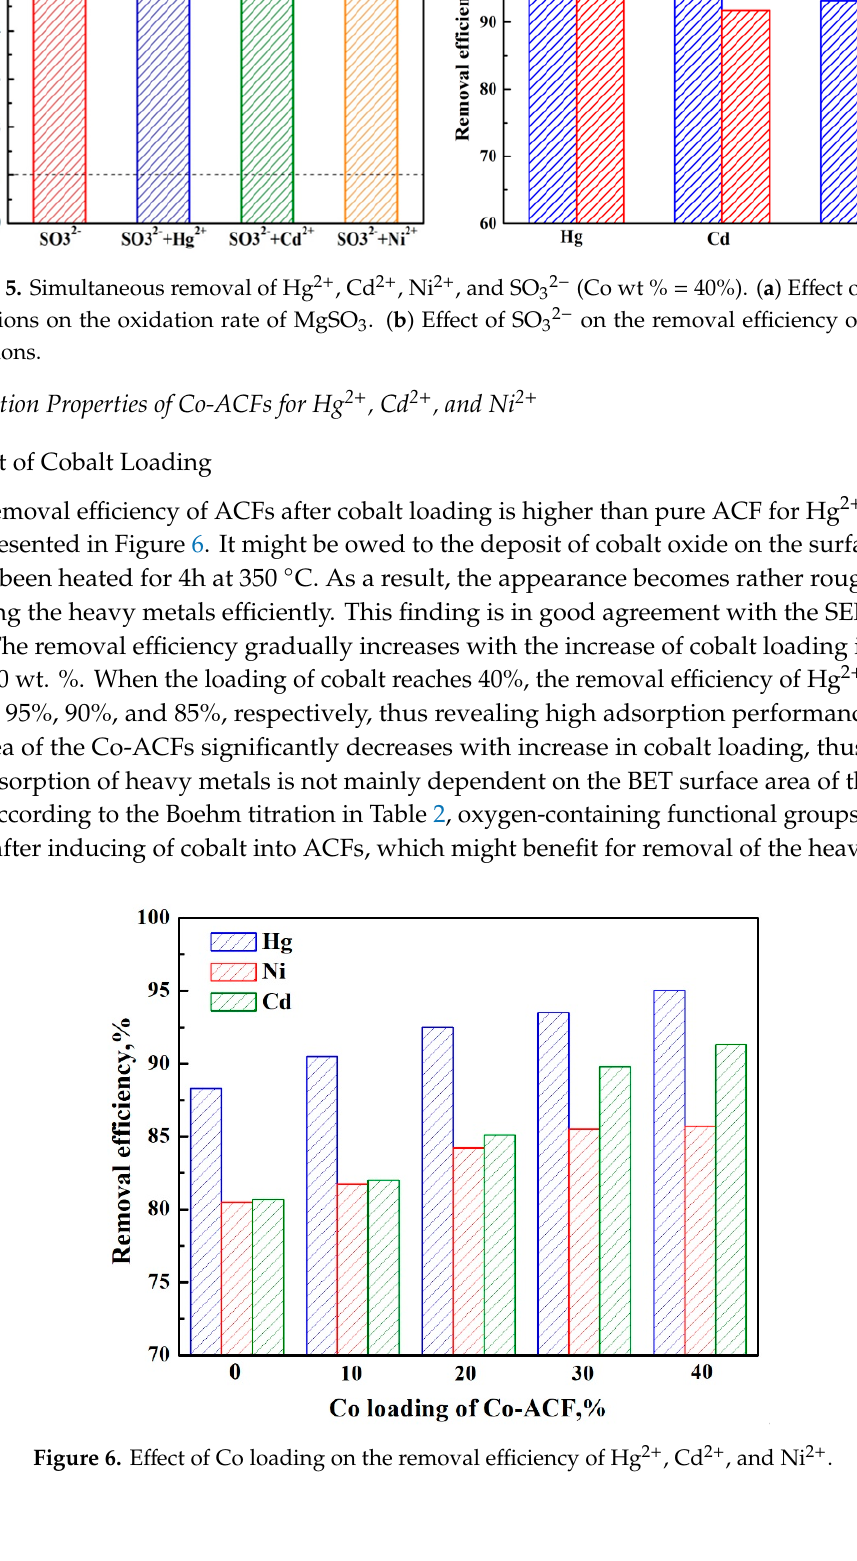
Figure 6. Effect of Co loading on the removal efficiency of Hg 2+ , Cd 2+ , and Ni 2+ .